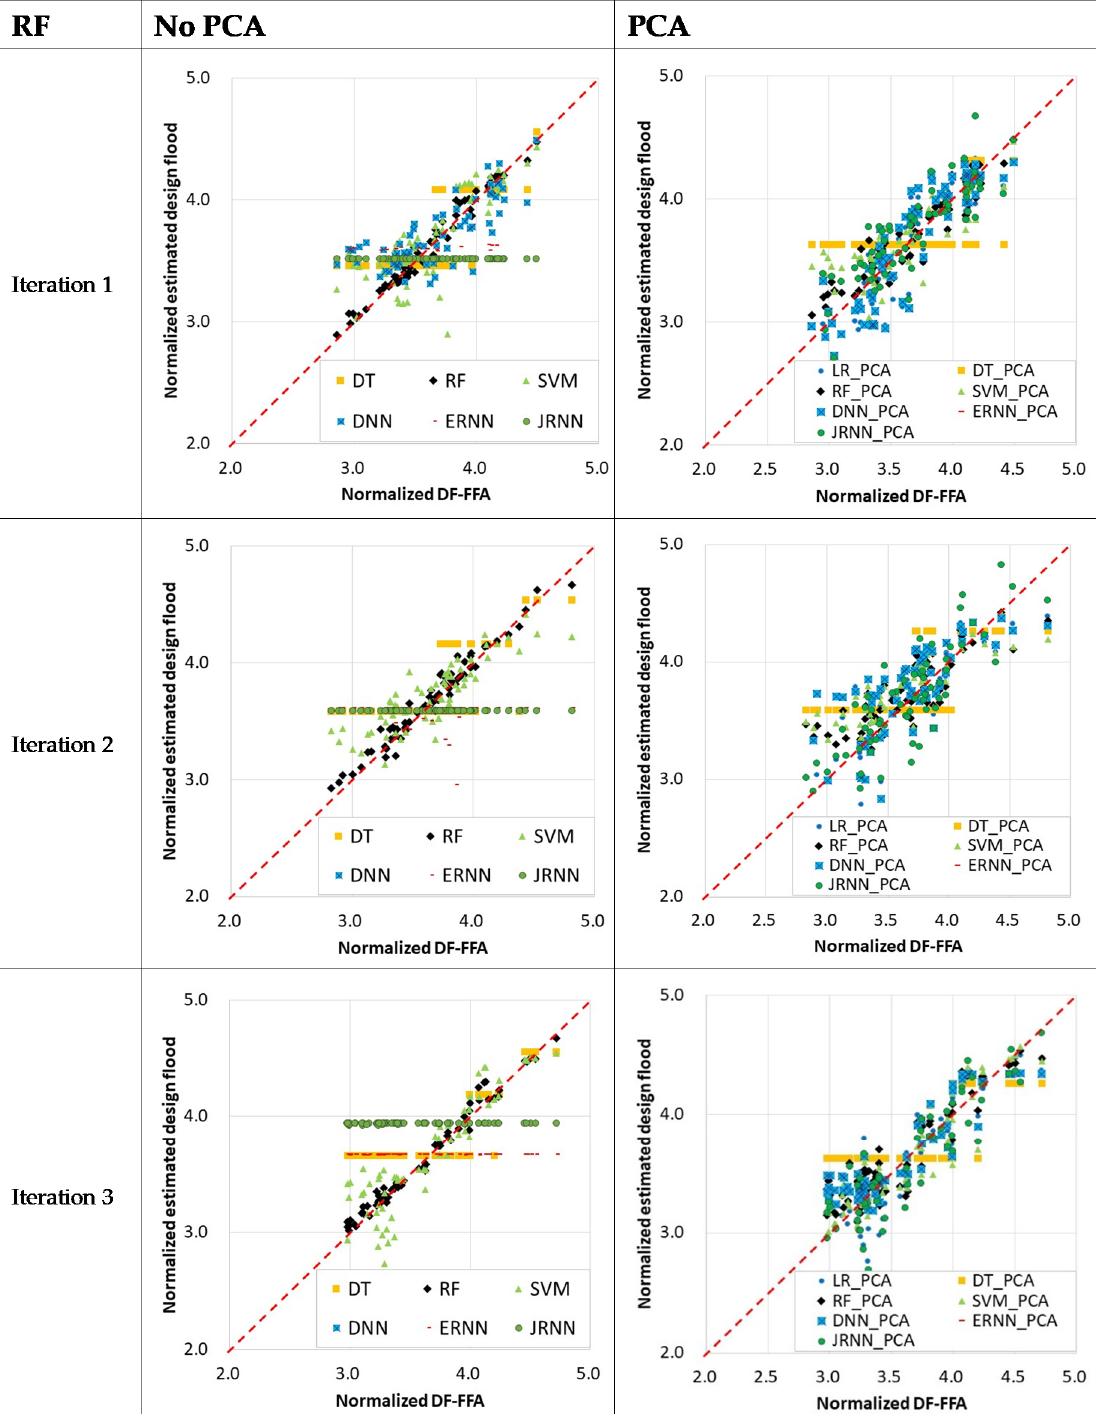
Figure 13. Performance assessment of design flood estimation models.